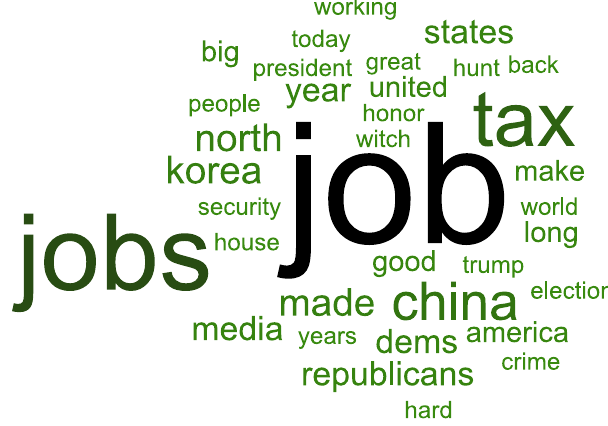
Fig. 5 Word cloud representation of the word pairs in tweets that were associated with signi fi cant diversion and suppression. The pair structure is ignored in this representation. Size of each word corresponds to its frequency, as does font color. The darker the font, the greater the frequency.